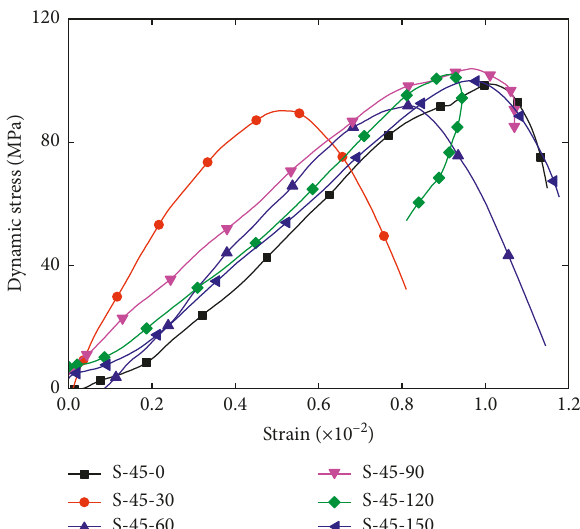
Figure 9: Influence of the ligament angle on the dynamic stress- strain curves of specimens with a constant flaw angle of 0 ° .